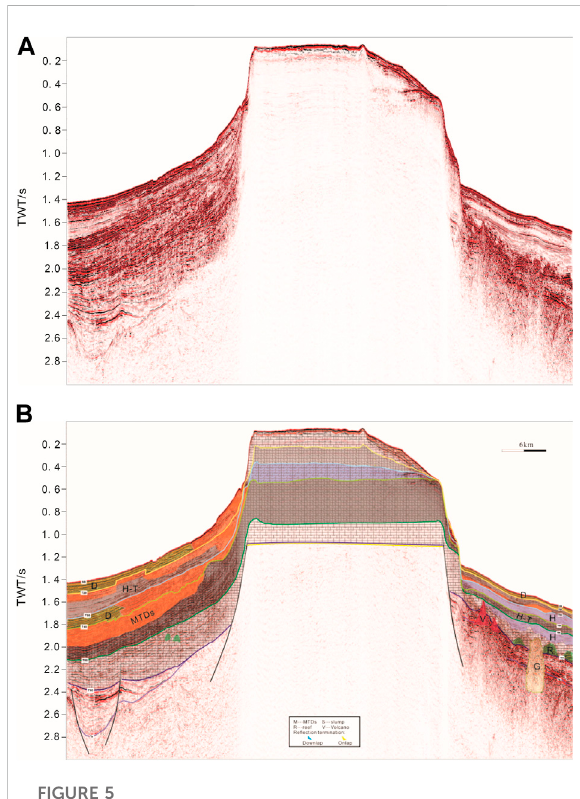
FIGURE 4 (A) Original and (B) interpreted sections of the seismic pro fi le XDS05.